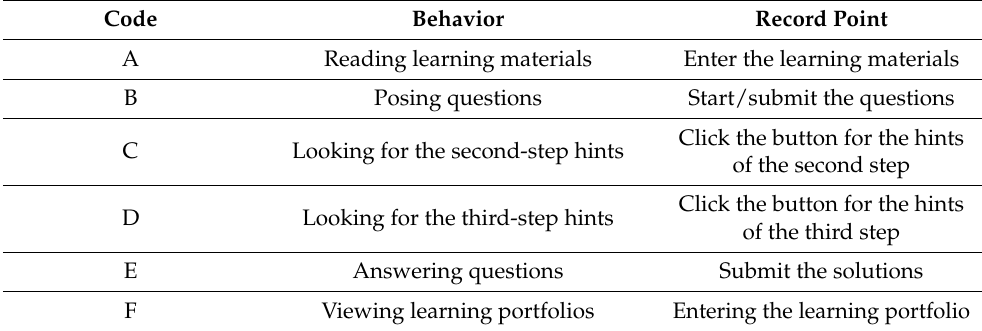
Table 4. The coding scheme of learning behaviors.